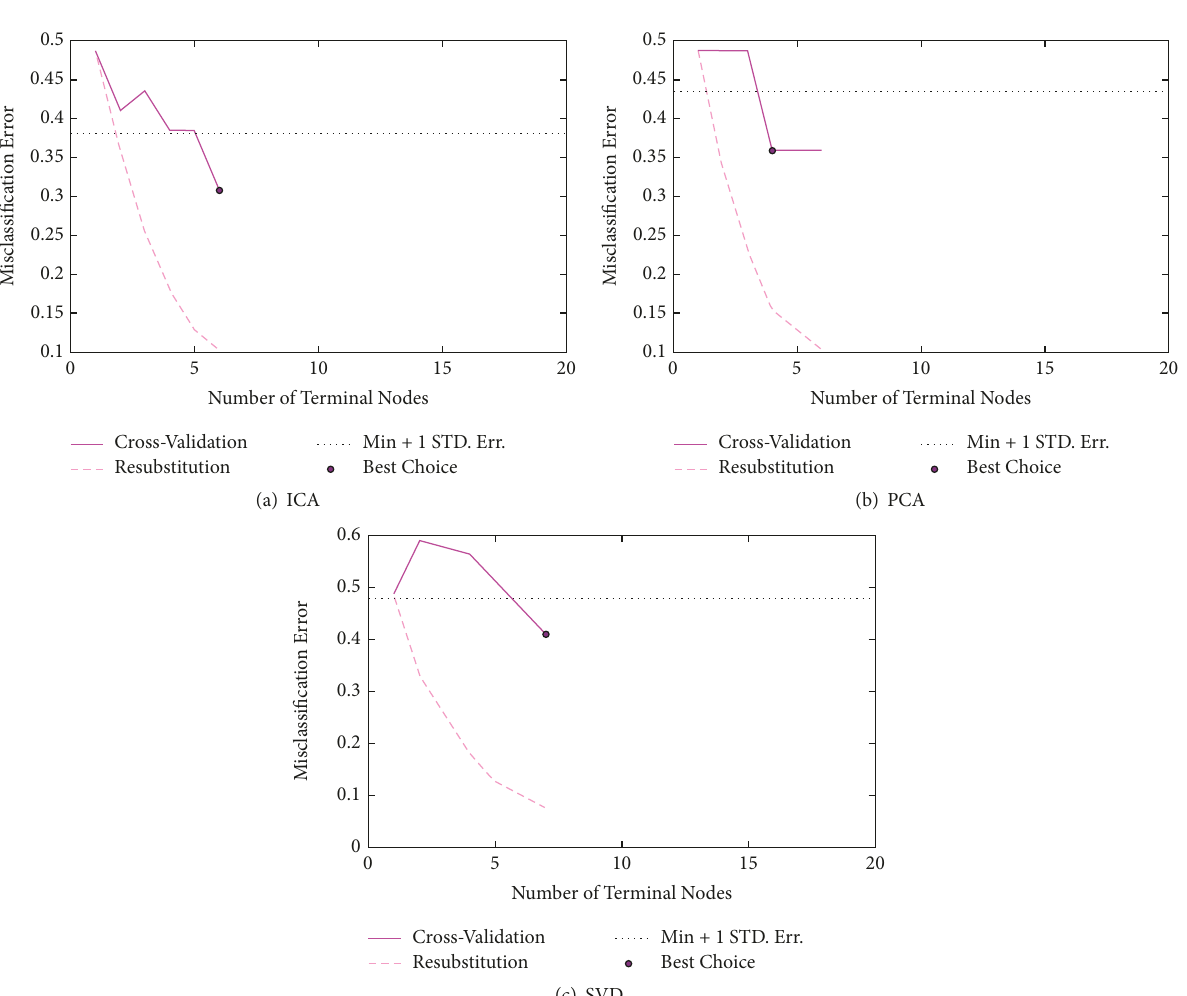
classification using the CART with different data reduction